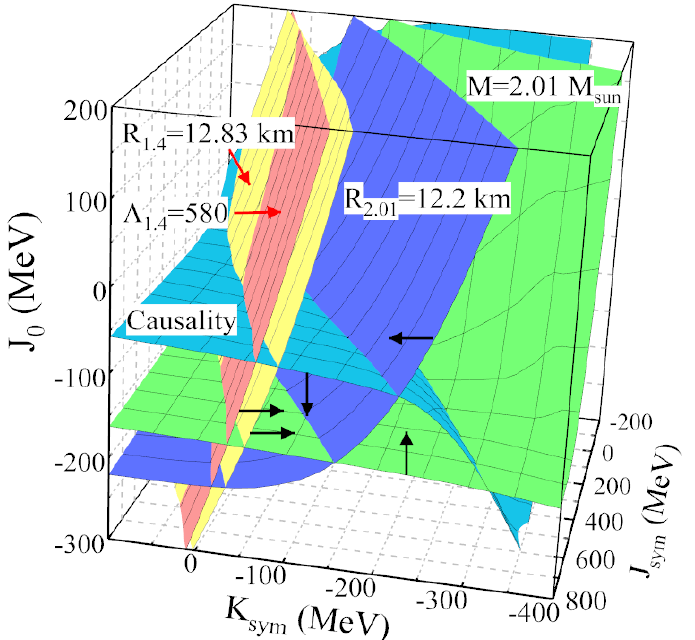
Figure 5. Similar to Figure 4, but with the constant surface of the minimum radius R = 12.2 km at a 68% confidence level for PSR J0740+6620 with a mass of 2.08 ± 0.07 M (cid:12) [108].